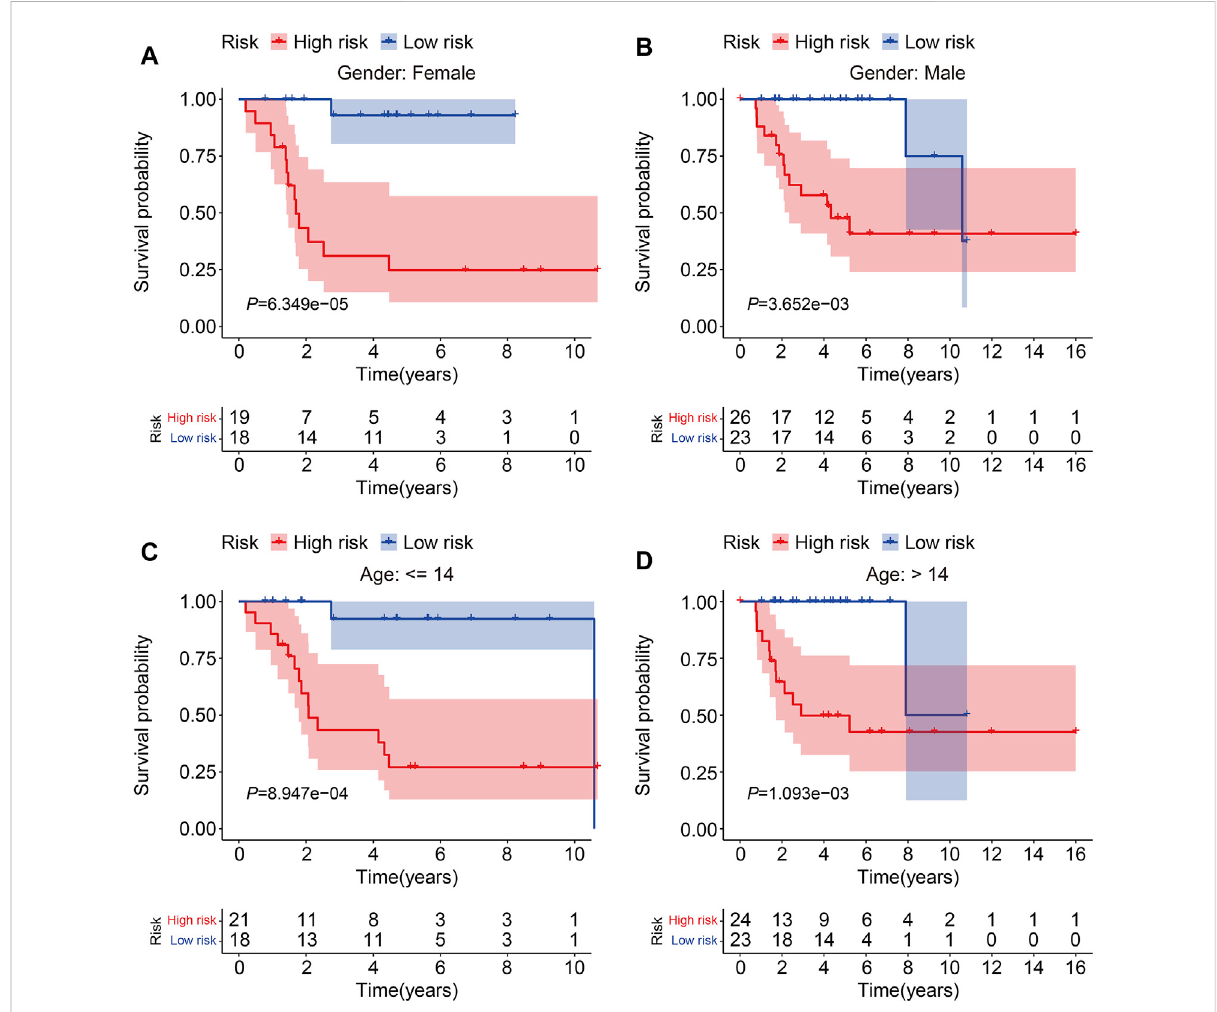
FIGURE 4 Kaplan – Meier survival curve analysis in different subgroups. (A,B) Comparison of the overall survival between high- and low-risk groups in subgroups classi fi ed by gender in the TCGA cohort. (C,D) Comparison of the overall survival between high- and low-risk groups in subgroups classi fi ed by age in the TCGA